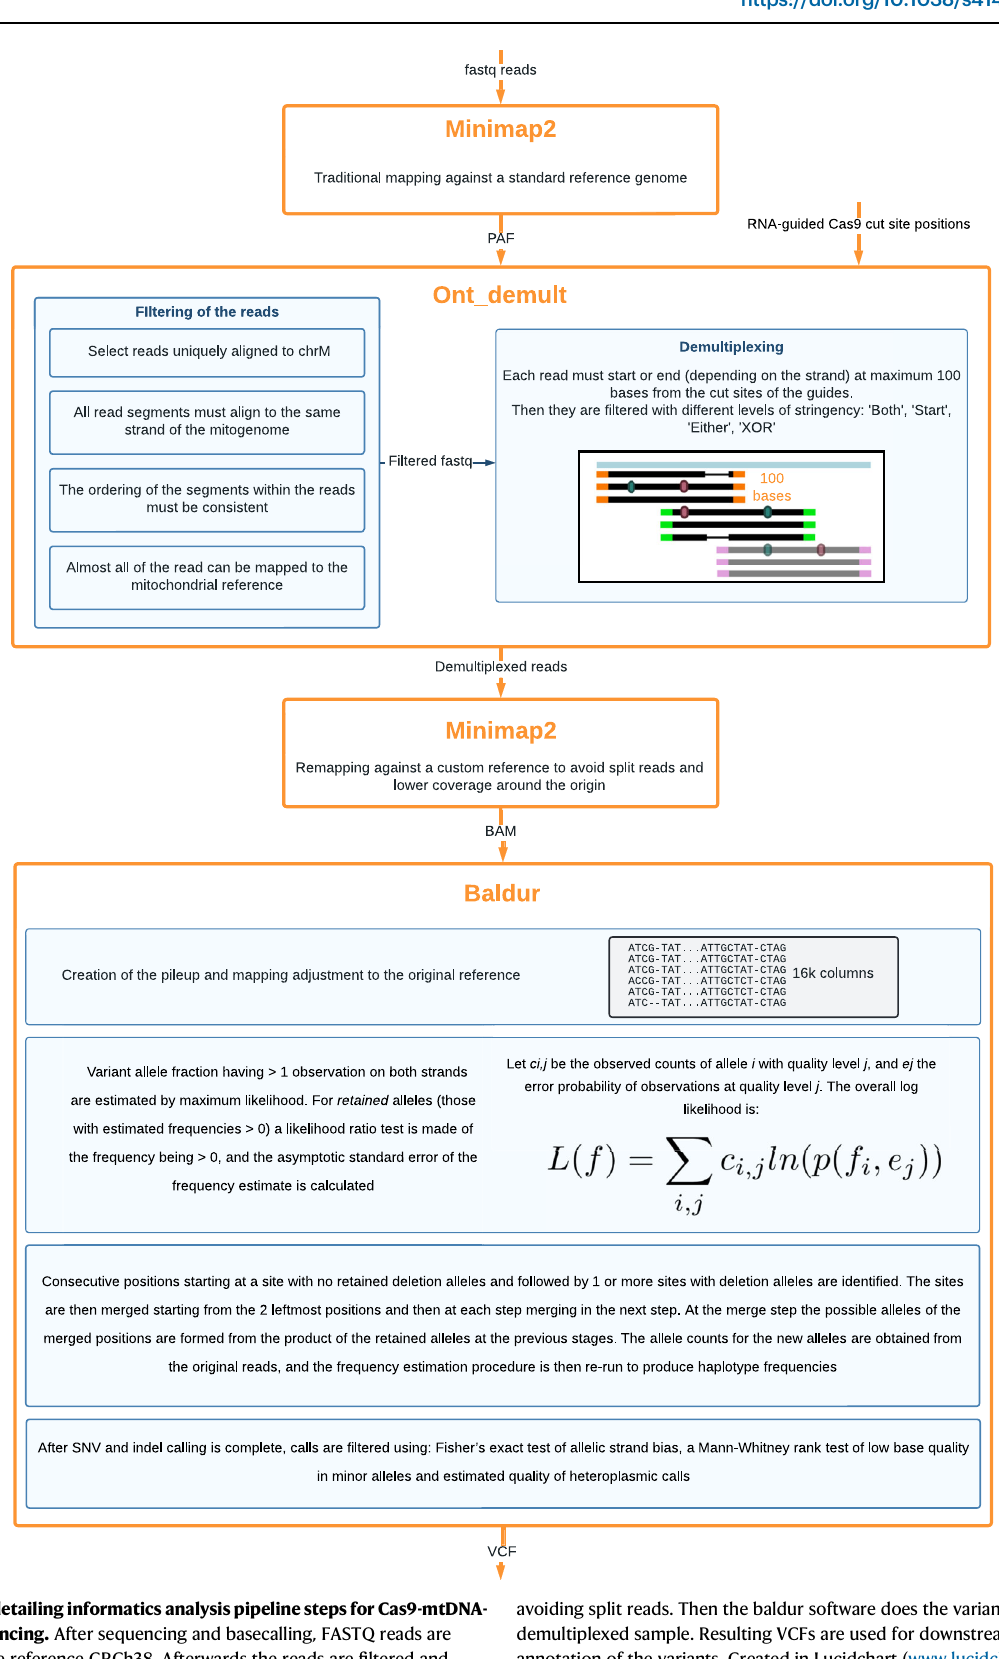
avoiding split reads. Then the baldur software does the variant calling for each demultiplexed sample. Resulting VCFs are used for downstream analysis for the annotation of the variants. Created in Lucidchart (www.lucidchart.com).